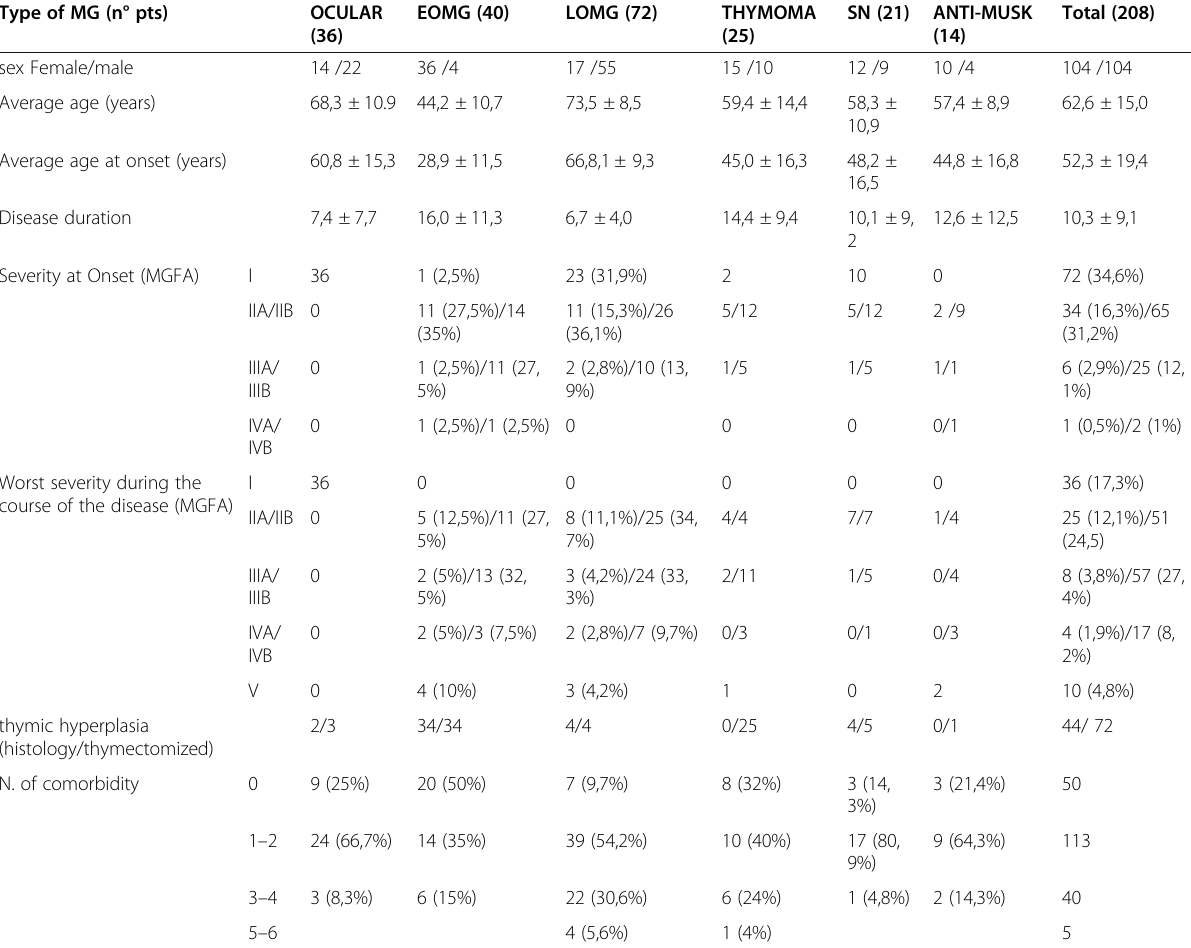
Table 1 Clinical characteristics of the sample Type of MG (n° pts)